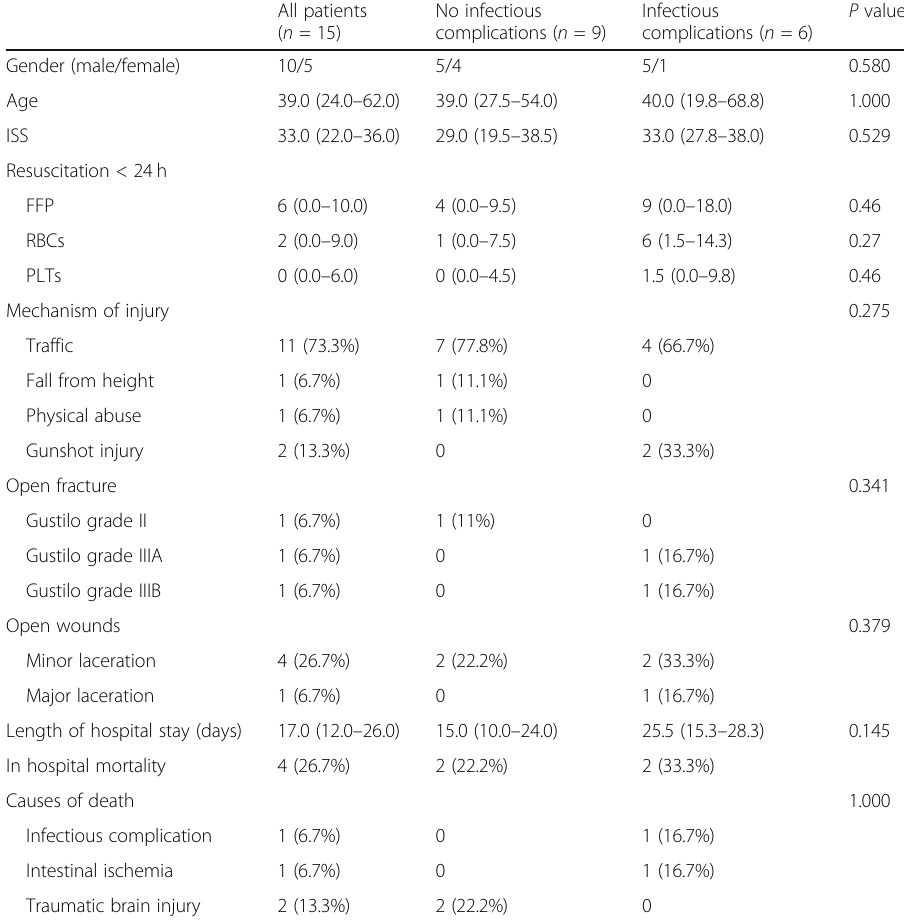
Table 1 Baseline and outcome characteristics